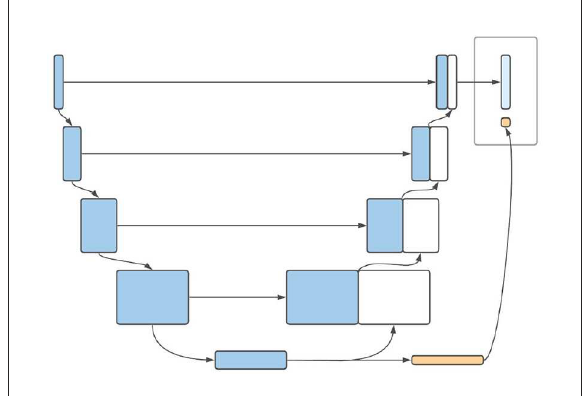
FIGURE3 Schematic illustration of the proposed architecture of AgeU-Net